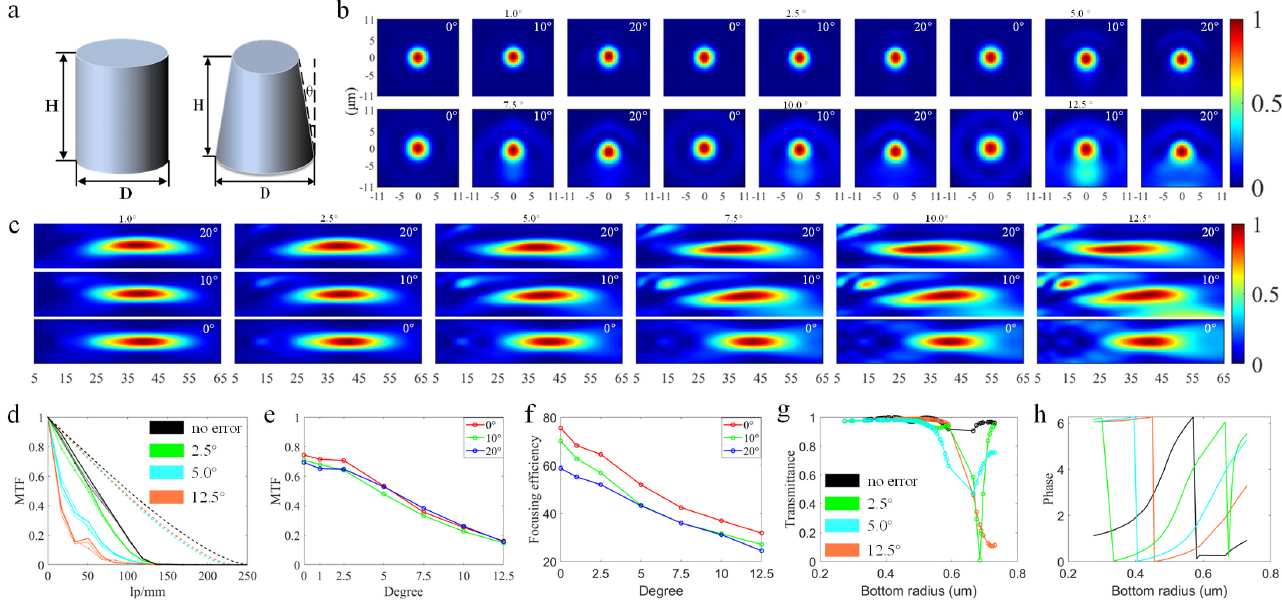
Figure 5. ( a ) Schematic diagram of inclined sidewall error. ( b , c ) Light intensity distribution along XY and XZ direction at different FOV under various error conditions. ( d ) MTF curves at different FOV under various error and no − error conditions, the double dash line represents the diffraction limit, the solid line represents the 0° FOV, the dashed line represents the 10° FOV, the dot − dashed line represents the 20° FOV (the diffraction limit at 2.5° error coincides with that at 12.5° error). ( e ) Line chart of MTF values at different FOV under various error and no − error conditions when the frequency is 33.33 lp/mm. ( f – h ) Focusing efficiency at different FOV, transmittance with different bottom radius of pillars, phase response with different bottom radius of pillars under various error and no − error conditions.